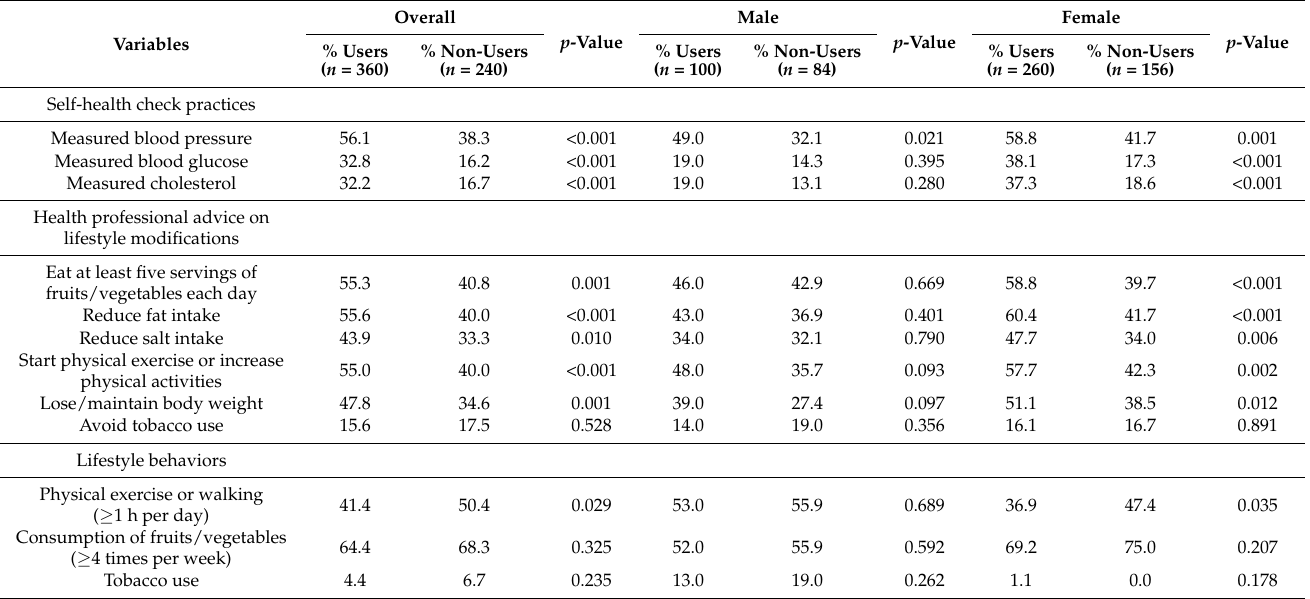
Table 4. Self-health check practices, receipt of health professional advice, and lifestyle behaviors by gender and status of health service use in the previous 12 months among schoolteachers in Afghanistan ( n = 600).